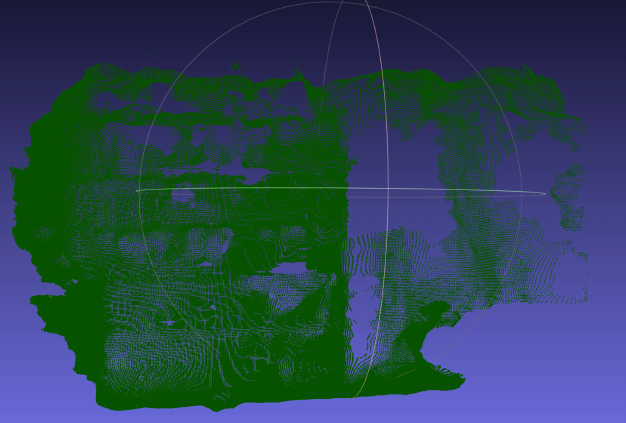
Figure 1. The 3D point cloud of a complex scene in the composition of objects, a bookcase is shown at 2 m away from the RGB-D camera, on the bookshelf stand out multiple volumes in the same